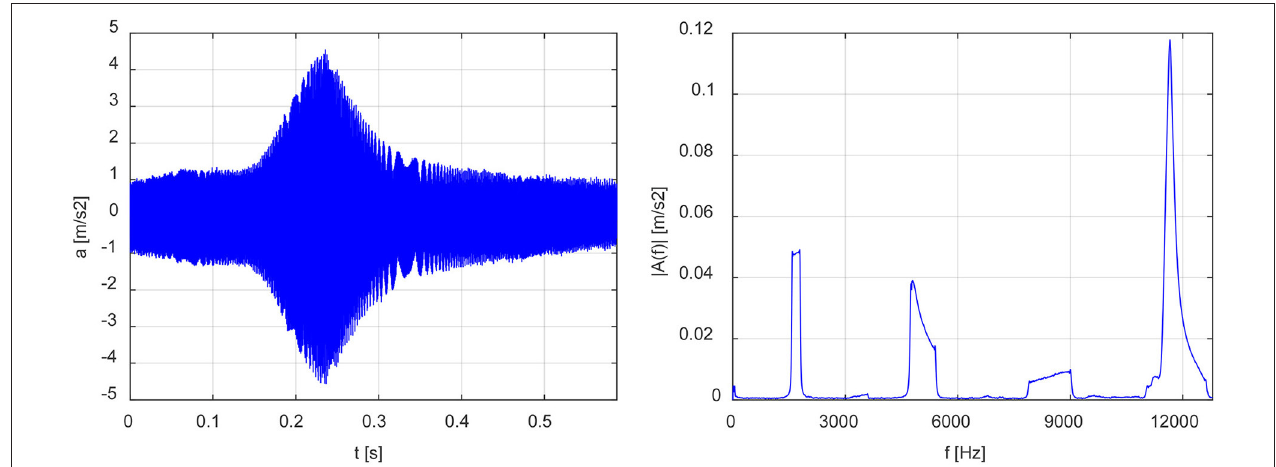
FIGURE 5 | Example of the windowed time history and the corresponding FFT. A linear swept-sine excitation with a start frequency of 1,000 Hz and an end frequency of 3,000 Hz has been applied in 10 s. Frequency limits of about 1,800 and 2,000 Hz have been imposed for the FFT.